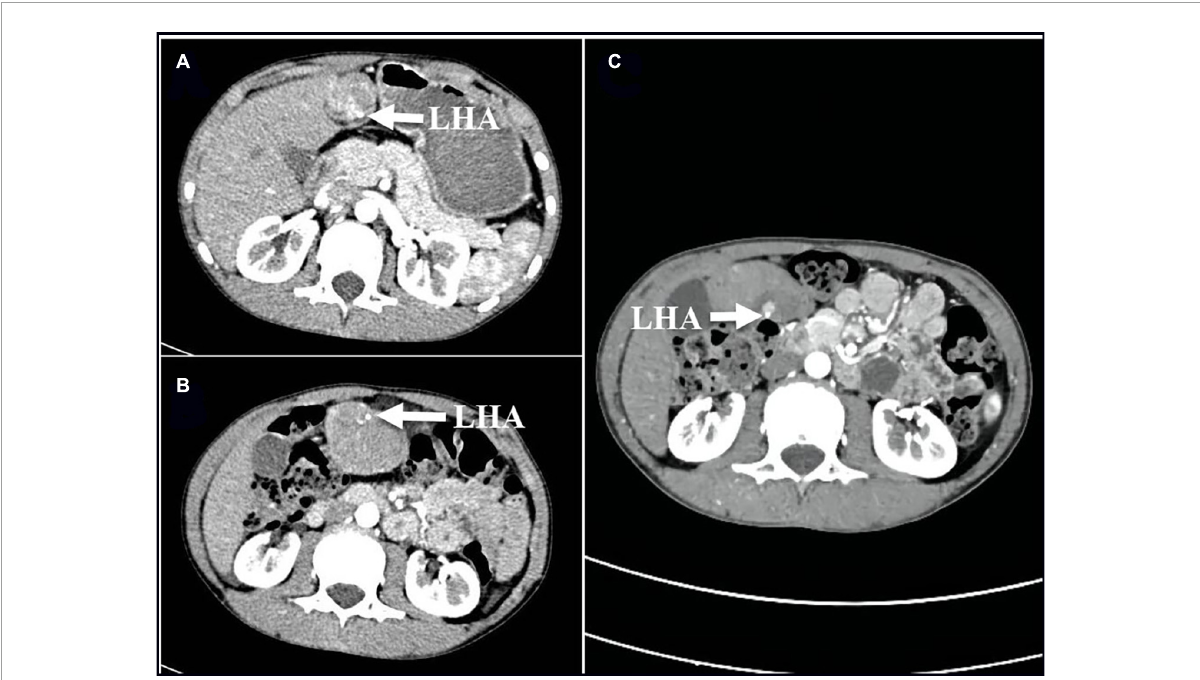
FIGURE1 (A,B) Cross-sectional images of the first enhanced CT scan before admission on 25 April 2021 show 180 ◦ torsion of the left hepatic artery (arrow); (C) On 27 April 2021, compared with the previous CT scan, the enhanced CT scans repeated after the disappearance of abdominal pain symptoms suggested that the twisted hepatic artery has reset itself (arrows). LHA, left hepatic artery; CT, computed tomography.